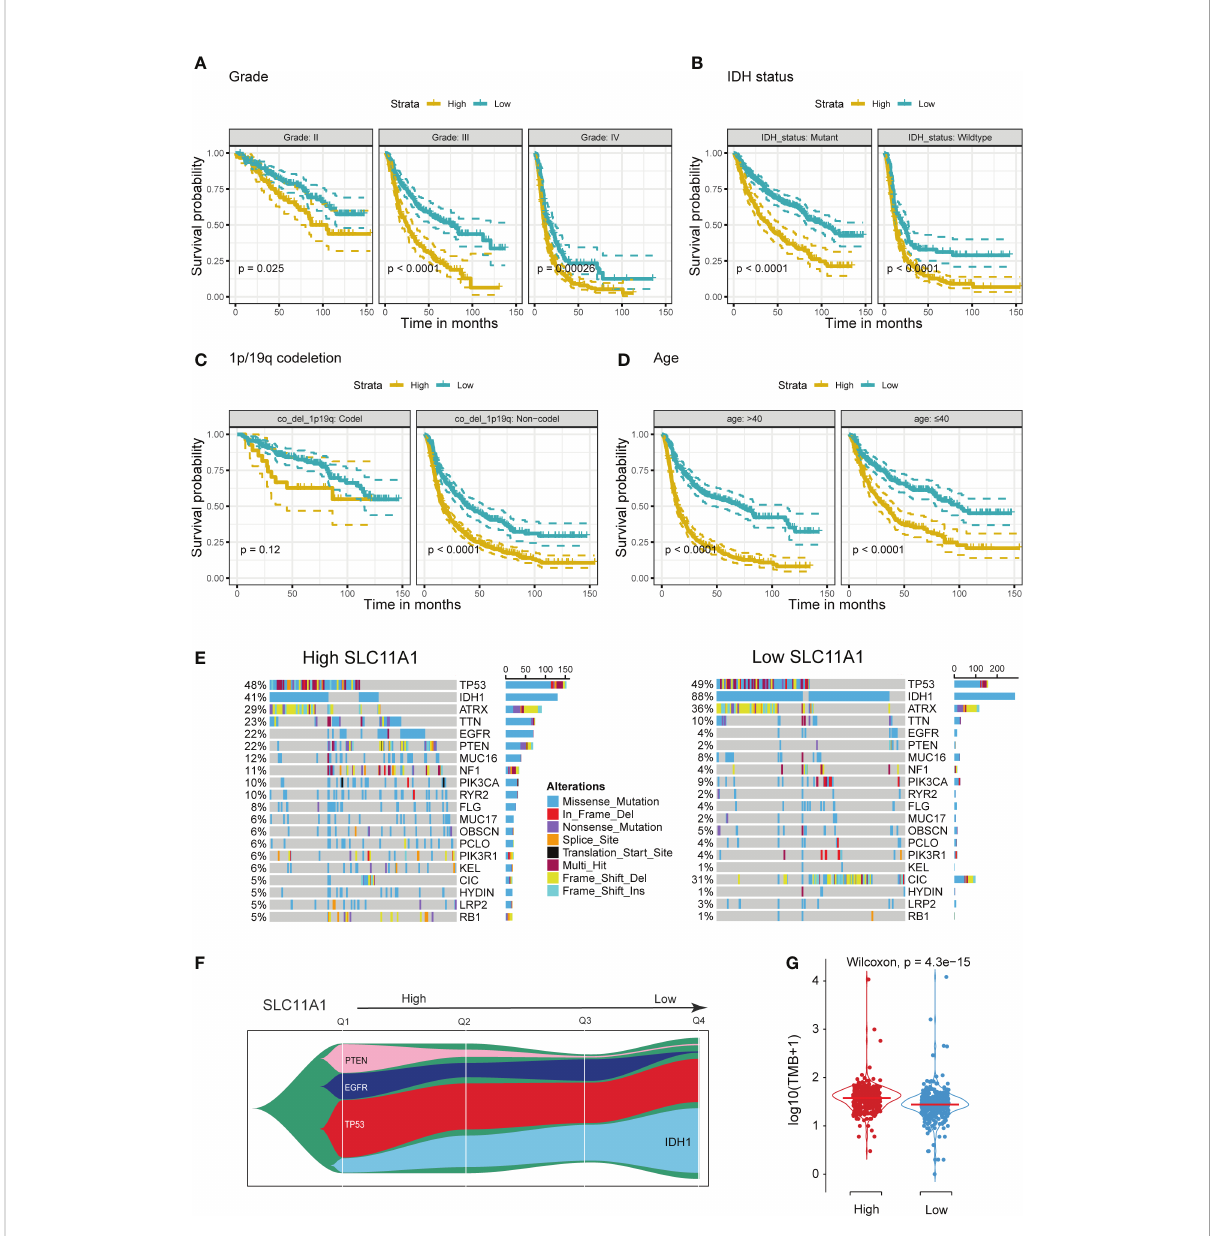
FIGURE 3 Strati fi cation Analysis and Mutation landscape of high/low SLC11A1 subgroups. High SLC11A1 expression predicts poor prognosis in gliomas with different clinical characteristics. Patients were divided into high and low expressed group by the medium expression level. Kaplan-Meier plots of SLC11A1 were performed with a variety of clinical characteristics. (A) tumor grade, (B) IDH mutational status, (C) 1p/19q co-deletion, and (D) Age. (E) Oncoplots showed the top 20 genes of mutations in patients with high expression of SLC11A1. (F) Fishplot showed that with SLC11A1 ’ s expression changing from high to low, IDH1 mutations progressively account for the dominant type of total mutations. (Q: quartile) (G) Violin plot showed higher tumor mutation burdens in patients with high SLC11A1 expression compared to those with low SLC11A1